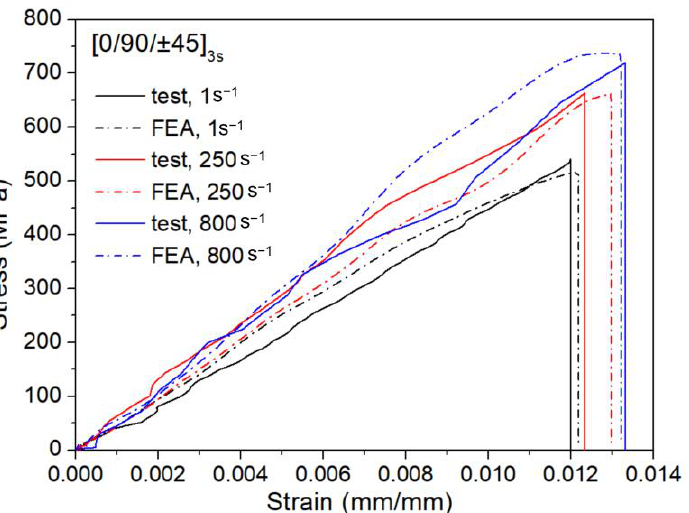
Figure 4. Comparison of simulated and experimental stress–strain curves for [0/90/ ± 45] 3s .